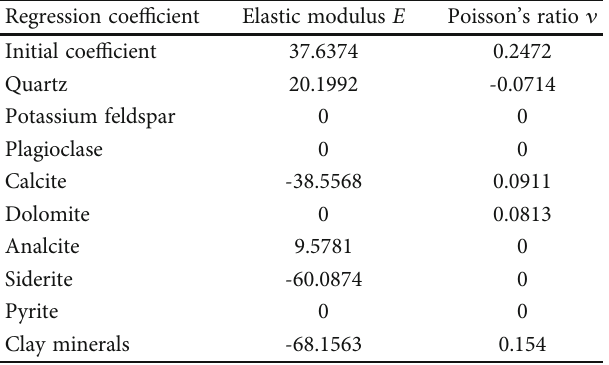
Table 4: Stepwise regression analysis results.